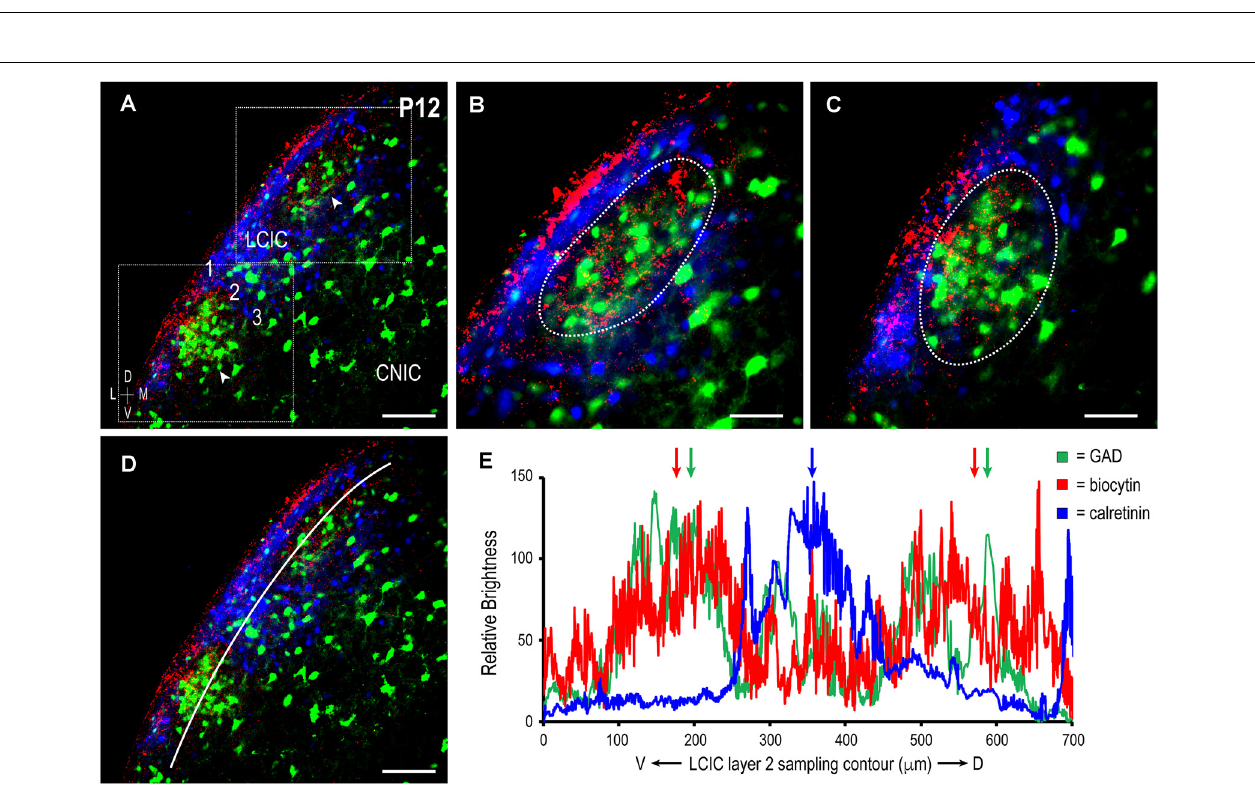
FIGURE 5 | Descending projections arising from somatosensory cortex target discrete LCIC modular fields and avoid the matrix in another P12 mouse. Digital merge of GAD (green), biocytin (red), and calretinin (blue) in a mid-rostrocaudal LCIC section (A) . Higher magnification images (B,C) of corresponding insets boxes in (A) show highly refined terminal patterns in two adjacent LCIC modules. Note that axonal labeling is most concentrated within GAD-defined modules (dashed contours), and sparse at this time point in the encompassing CR-positive matrix. ROI layer 2 LCIC sampling for each channel (D) yields signal periodicities in (E) that exhibit either strong overlap (somatosensory and GAD, green and red arrows) or striking mismatch (CR, blue arrow, relative to somatosensory and GAD). Scale bars in (A,D) = 100 µ m, (B,C) = 50 µ m.